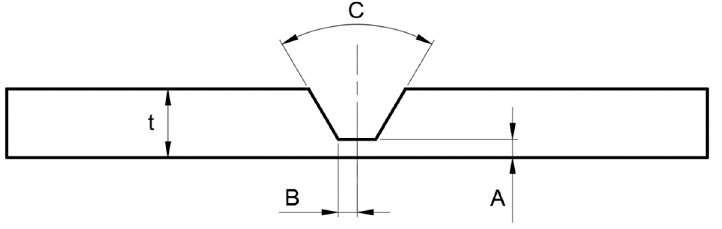
Figure 3. Geometry of the welding surfaces: A = 1 mm, B = 1 mm, C = 60°, t = 15 mm.